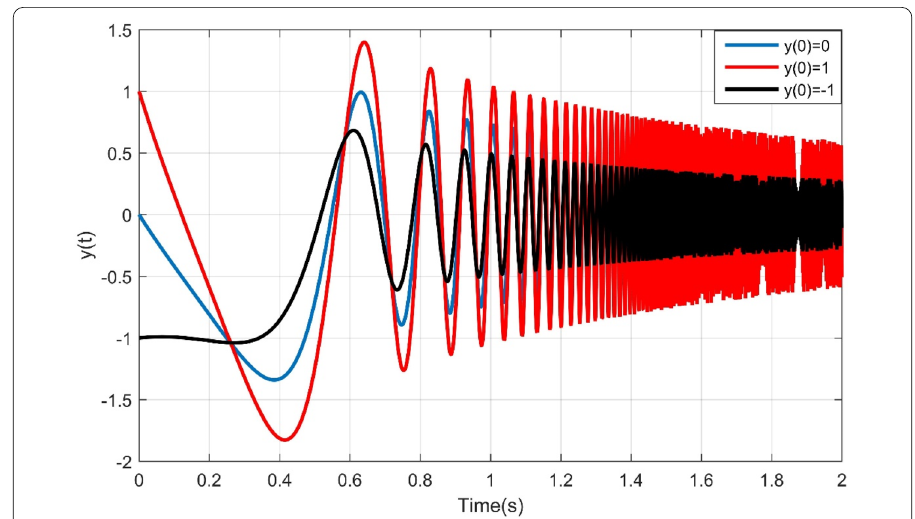
Figure 6 Trajectories of y ( t ) for Example 2 when y (0) = 0, y (0) = 1 and y (0) =